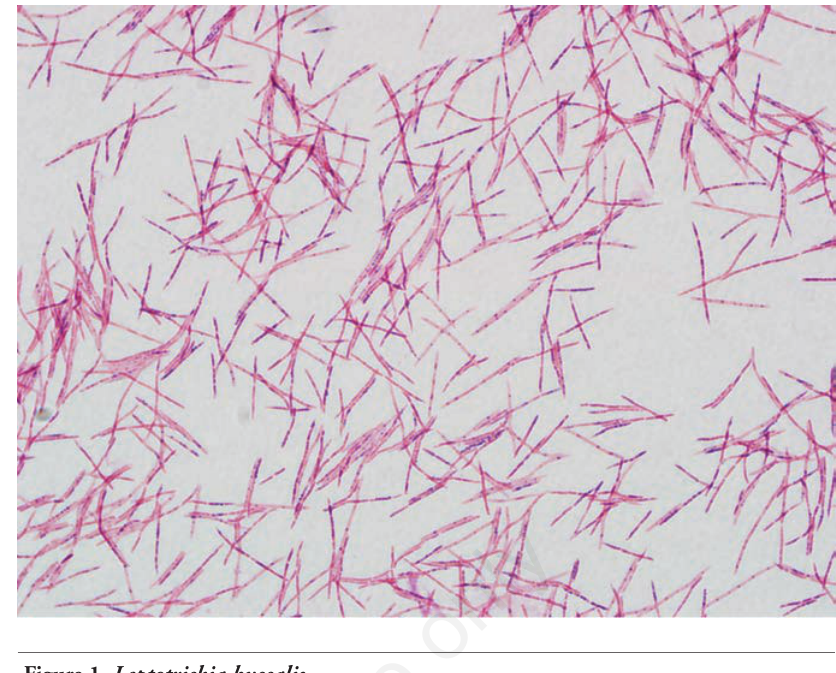
Figure 1. Leptotrichia